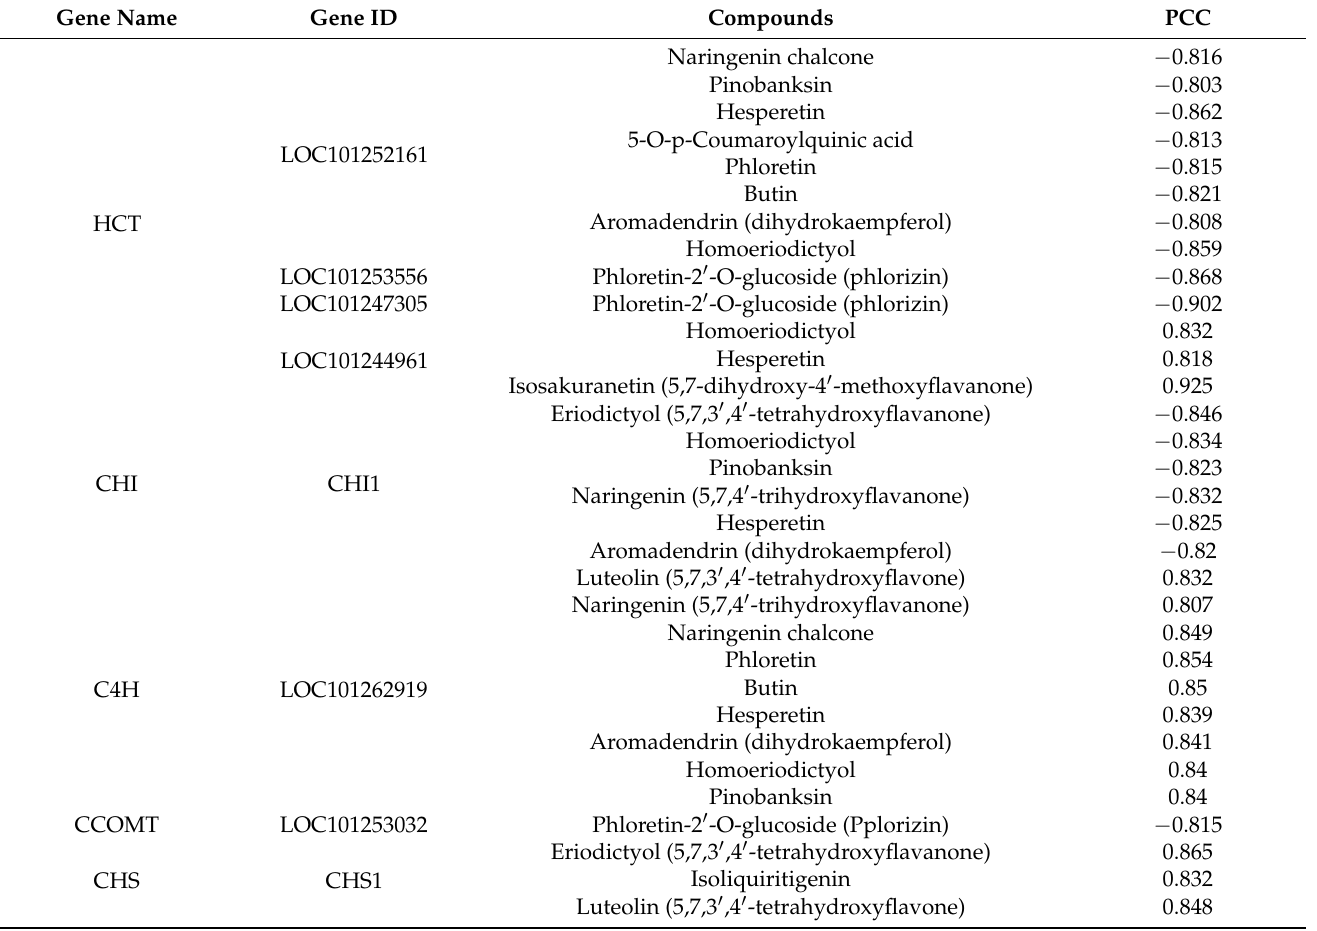
Table 5. Result of flavonoid correlation network